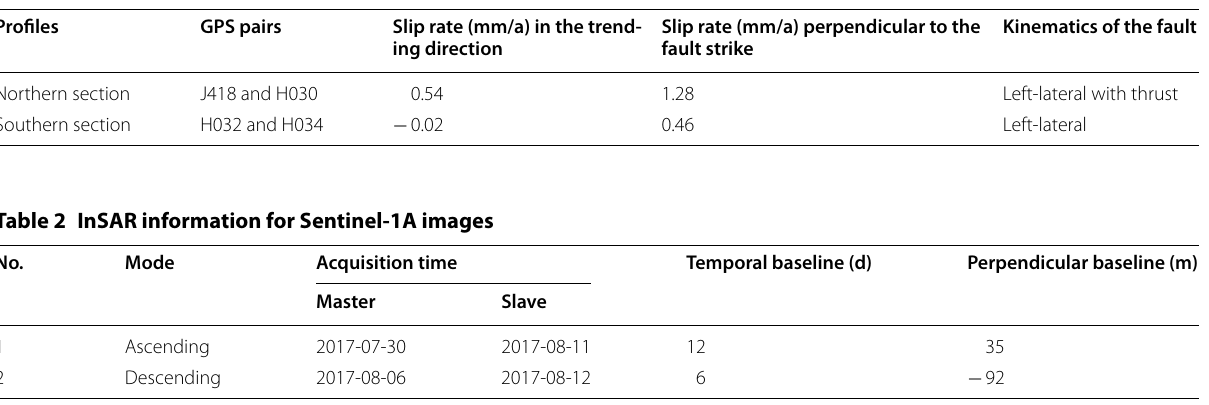
Table 2). The coseismic deformation field of LOS